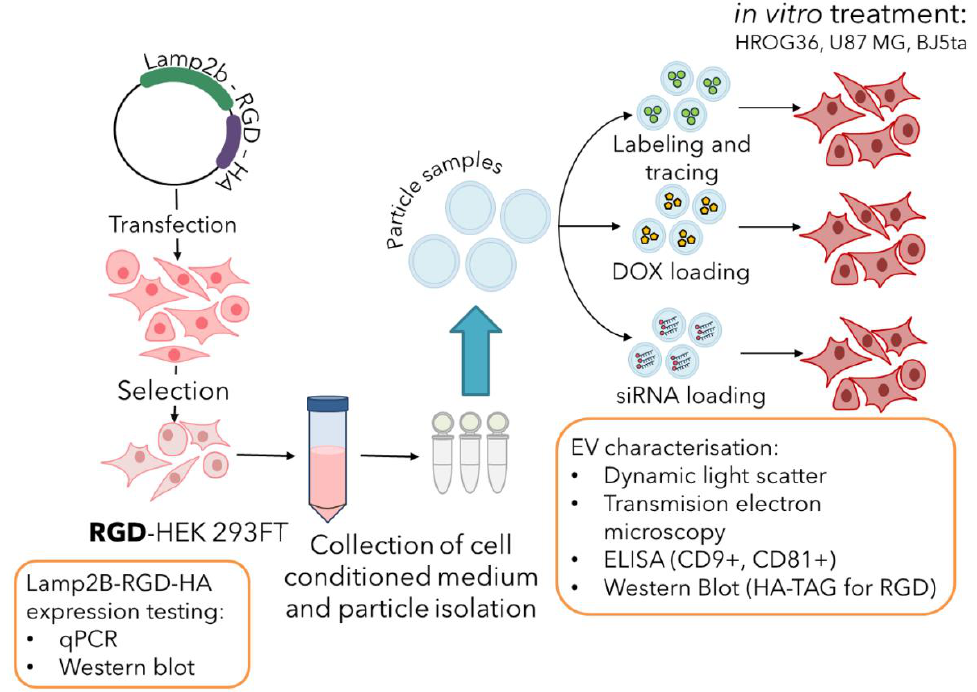
Figure 1. Experimental design of the study. The study was divided into three parts: (1) generation of a stable Lamp2b-RGD-HA HEK 293FT cell line; (2) isolation and characterisation of EVs; (3) downstream analysis, which includes EV internalisation studies, the delivery of doxorubicin hydrochloride (DOX) and the delivery of siRNA against the glyceraldehyde 3-phosphate dehydrogenase (GAPDH) gene.